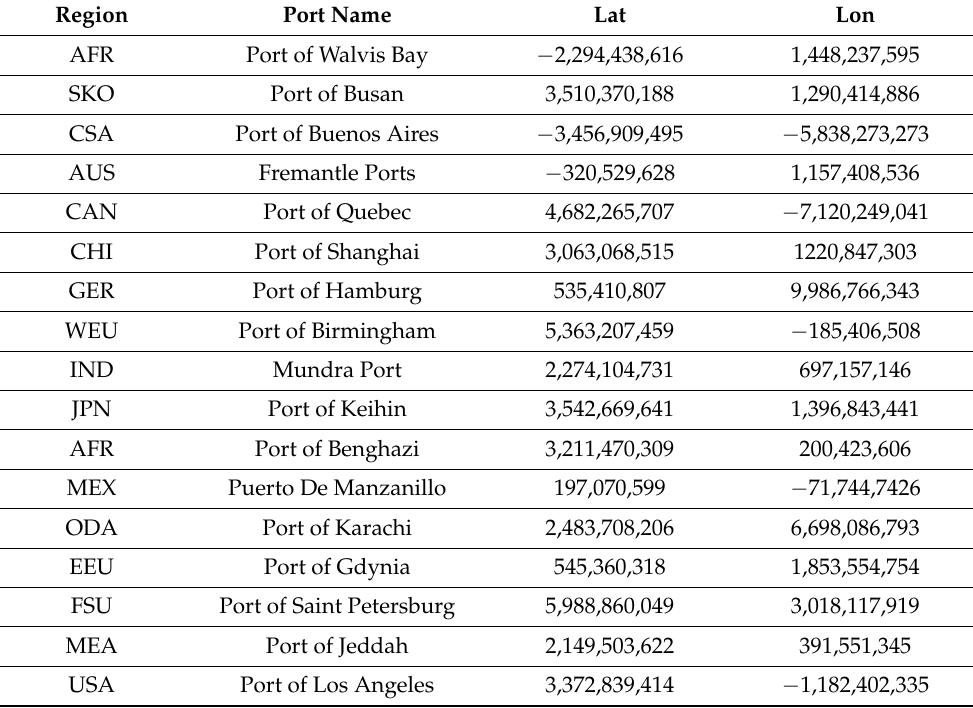
Table A2. Ports in TIAM for hydrogen and synfuel import and export. This is our own